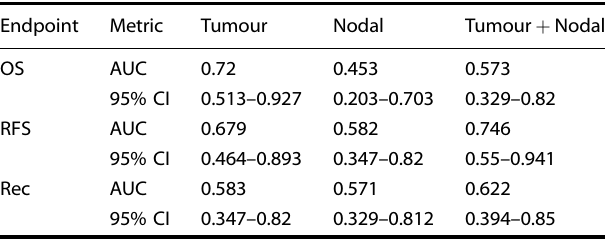
Table 3. Validation set AUC and 95% CIs for models built using radiomic features extracted from the primary tumour only, largest nodal volume only, and these features combined.